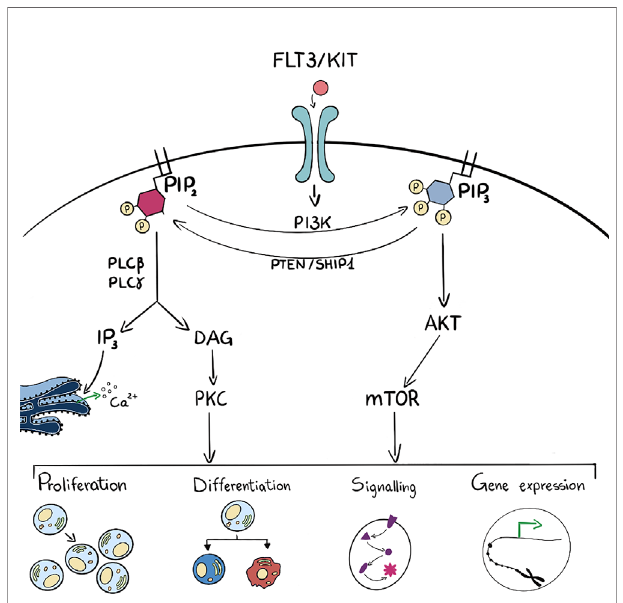
FIGURE 2 | Schematic representation (on the left side) of PLC activation which hydrolyses PIP 2 into DAG and IP 3 . These last two are intermediate second messengers that can regulate many cell functions such as proliferation, differentiation, signal transduction and gene expression. On the right side, ligand binding to membrane receptor drives PI3K activation and consequent phosphorylation of PIP 2 into PIP 3 and subsequent activation of the AKT/mTOR pathway. These activated players can as well regulate many cell functions such as proliferation, differentiation, signal transduction and gene expression. PIP 3 can be dephosphorylated to PIP 2 by phosphatases such as PTEN and SHIP1. Many intermediate players are omitted for fi gure